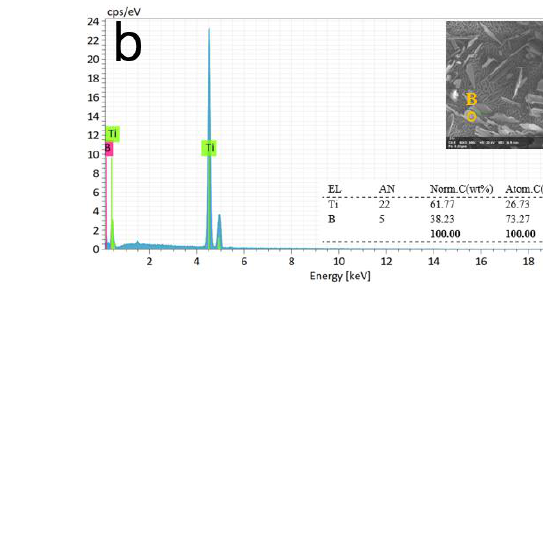
13 of 18 Figure 11. Energy spectrum analysis at different spots of processing time at 20 s. Different colored circles indicate measurement points at various locations. ( a ) Matrix material. ( b , c ) Reinforcing phase particles attached to the matrix. In Figure 11a, point A had a honeycomb-like pattern inside the matrix material[38]. The elemental composition of the measurement results was Ti, Al, and V; therefore, the material at point A was matrix TC4 (Ti-6Al-4V). The orange circle in Figure 11b represents measurement point B. The selected point was a long, rod-like reinforcing phase. The ele- mental composition in the measurement results was Ti and B; therefore, the material at point C was a TiB-reinforced phase material. The red circle in Figure 11c represents meas- urement point C, which was a TiC-reinforced phase material. Compared with Figure 10, the entire surface layer has completely dissolved with time. The white area of the oxida- tion product is no longer observed. The reinforcing phase particles are clearly visible and inserted rather than deposited into the honeycomb-pattern matrix material TC4.